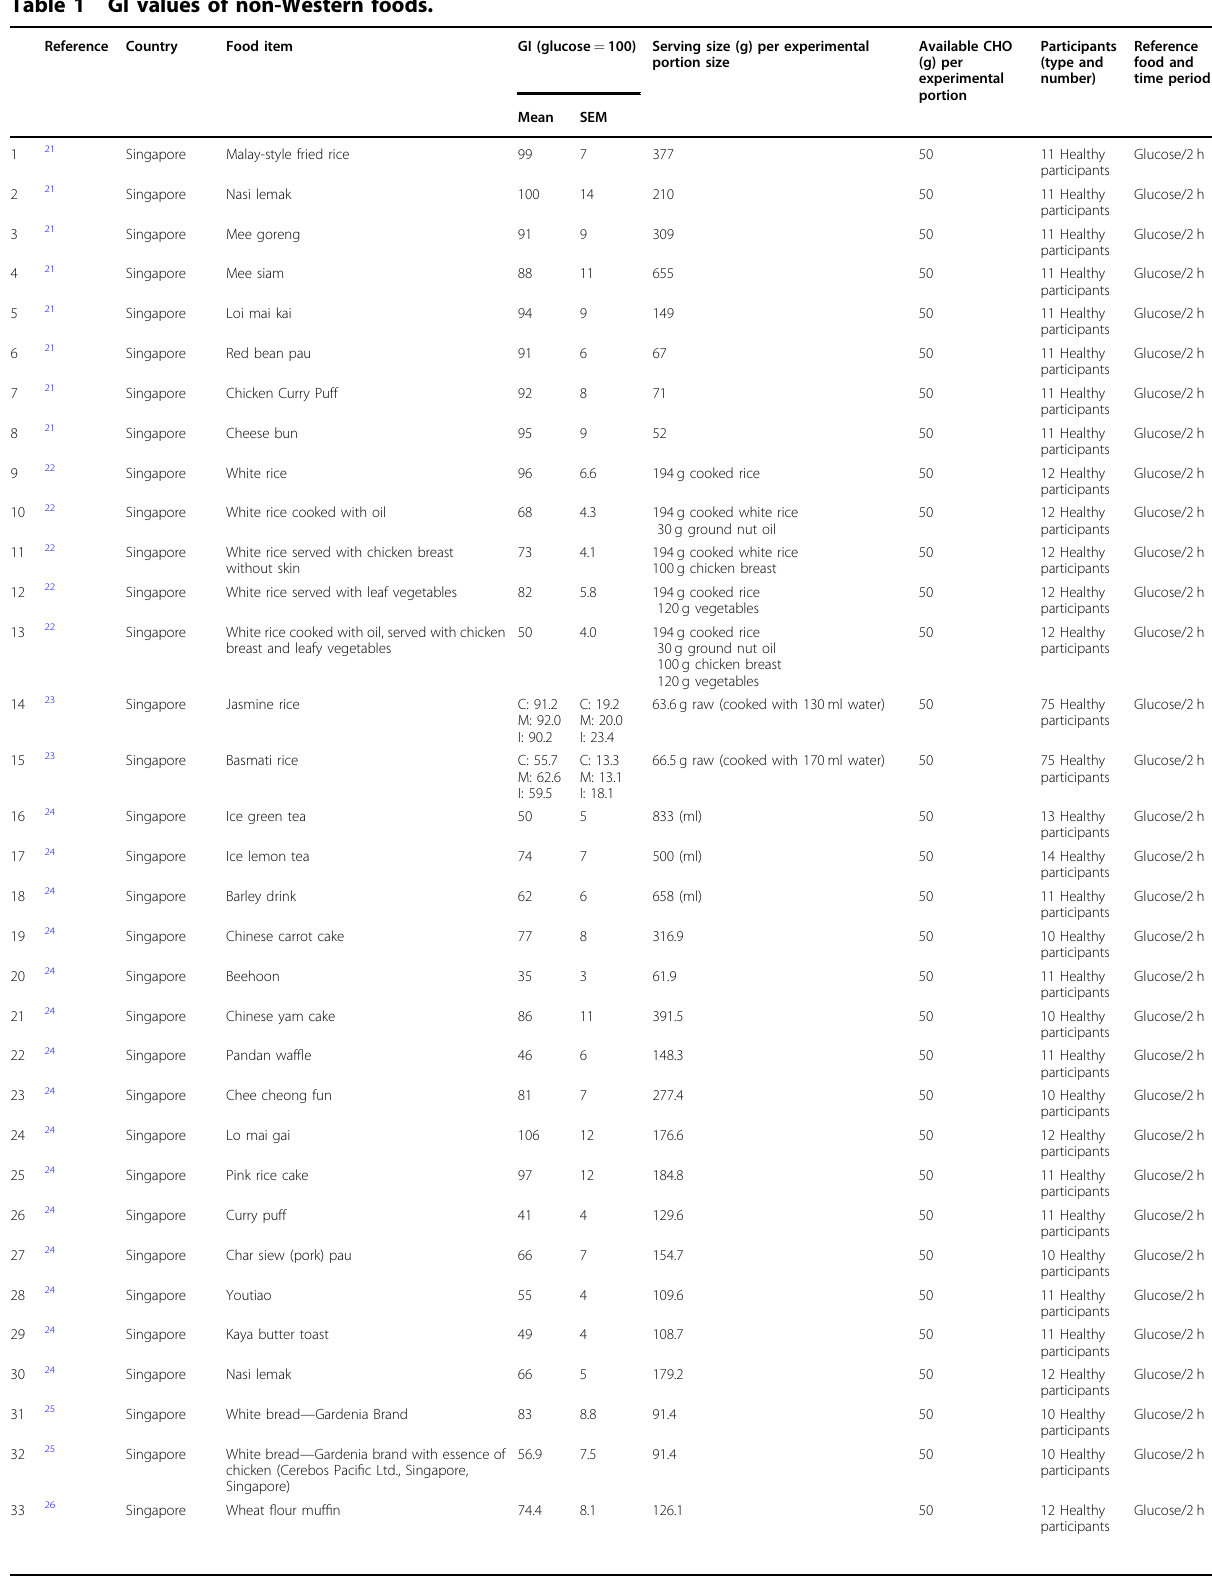
Table 1 GI values of non-Western foods. Reference